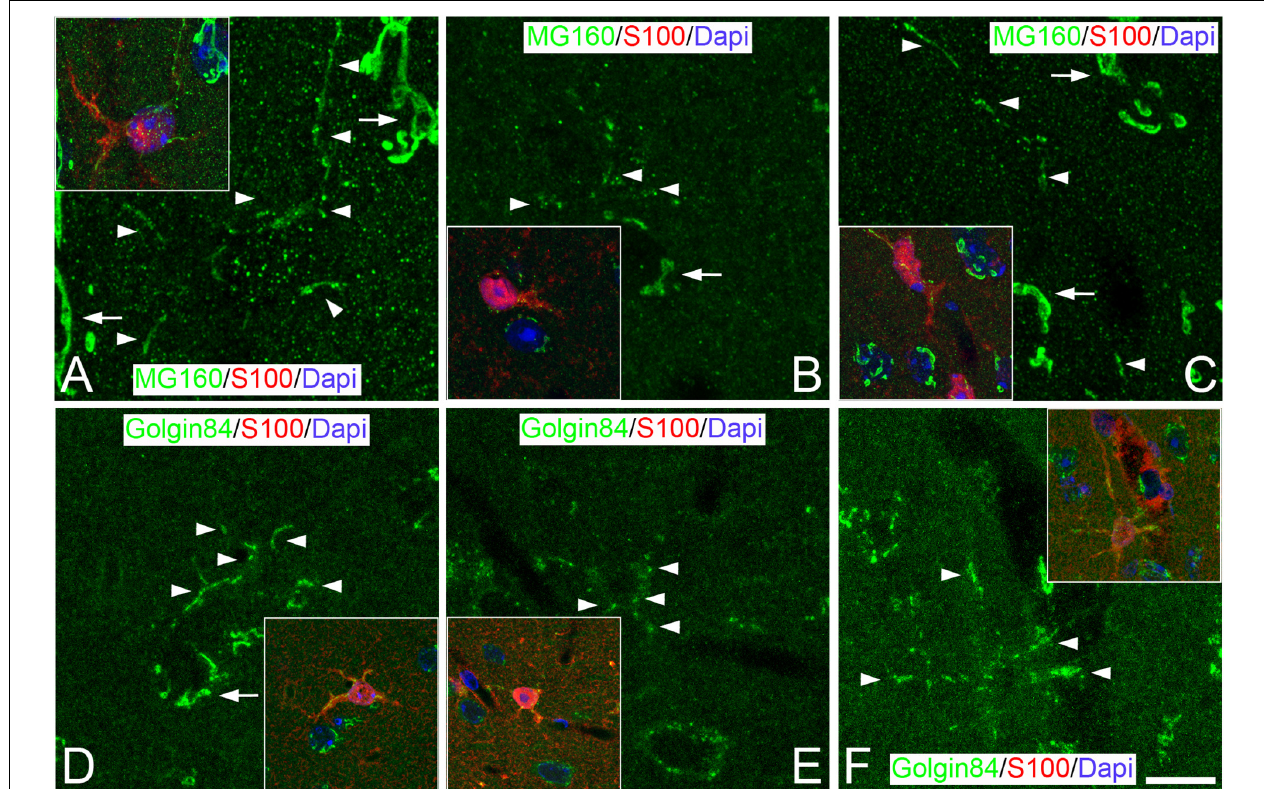
FIGURE 3 | Distribution of GA proteins in neocortical astrocytes throughout the hibernation cycle of the hamster. Images taken from neocortical sections double-immunostained for MG160/S100 (A–C) or Golgin 84/S100 (D–F) showing the distribution of GA proteins in the GA of astrocytes (identified by S100 immunostaining) from euthermic hamsters (A,D) , hamsters at torpor (B,E) , and arousal (C,F) . Note the apparent reduction in size and in intensity of MG160 immunostaining and the fragmentation of the GA elements of astrocytes during torpor and recovery in arousal. Scale bar shown in F indicates 7.2 µ m in all panels, and 15.8 µ m in the